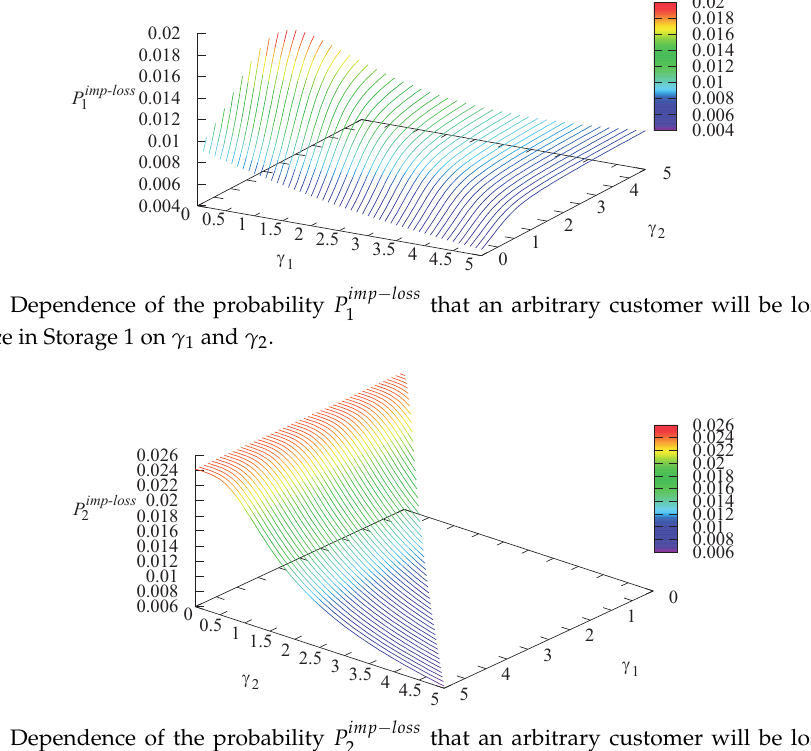
Figure 5. Dependence of the probability P imp impatience in Storage 2 on γ 1 and γ 2 .